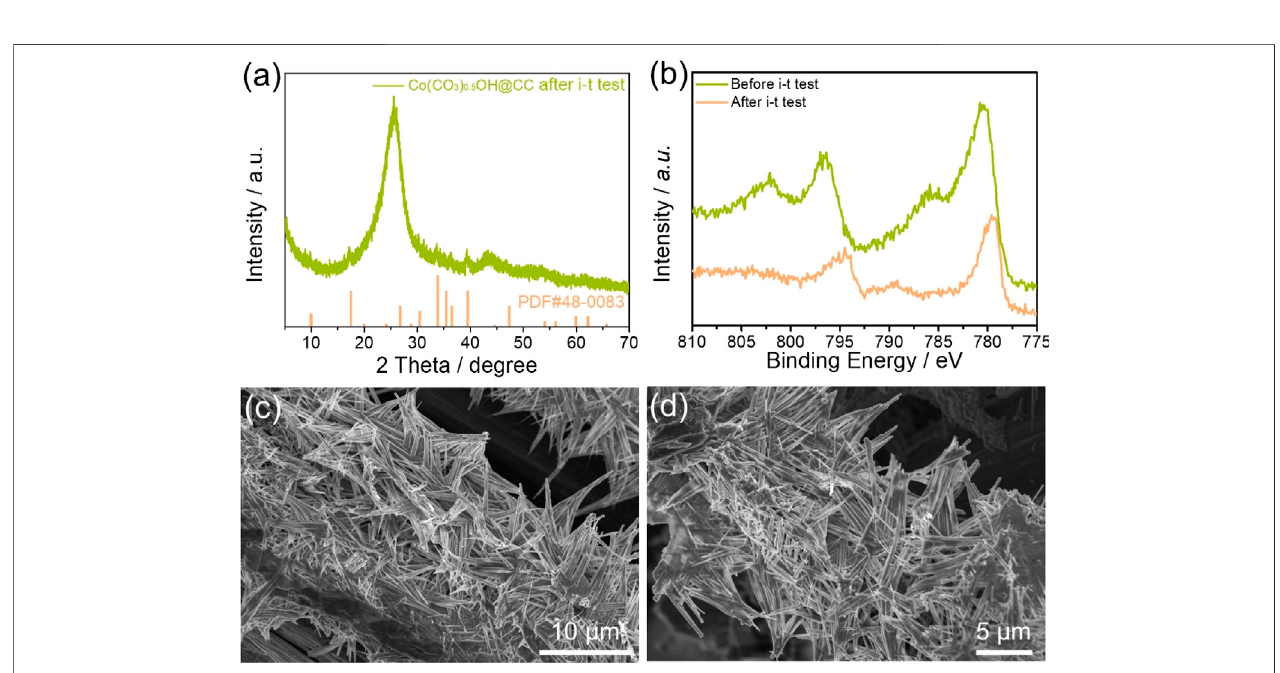
FIGURE5|(A) XRDpattern ofrecovered Co(CO 3 ) 0.5 OH@CC after i-t test; (B) High-resolution Co2p spectraofCo(CO 3 ) 0.5 OH@CC before and after i-t test; (C – D) SEM images of recovered Co(CO 3 ) 0.5 OH@CC.